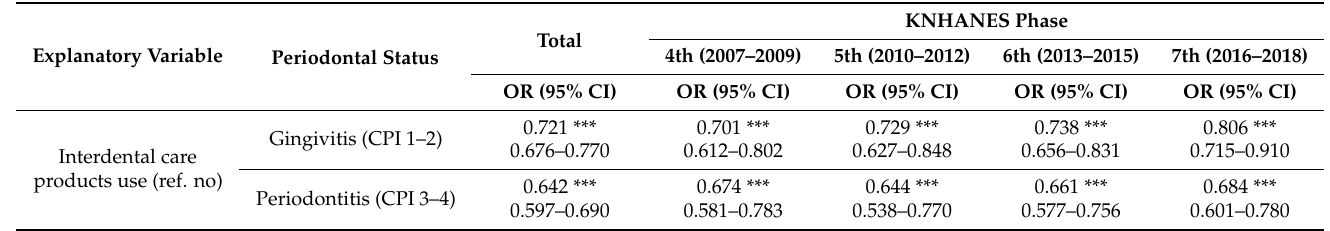
Table 3. Adjusted associations with the interdental care products use and periodontal status according to KNHANES phase.